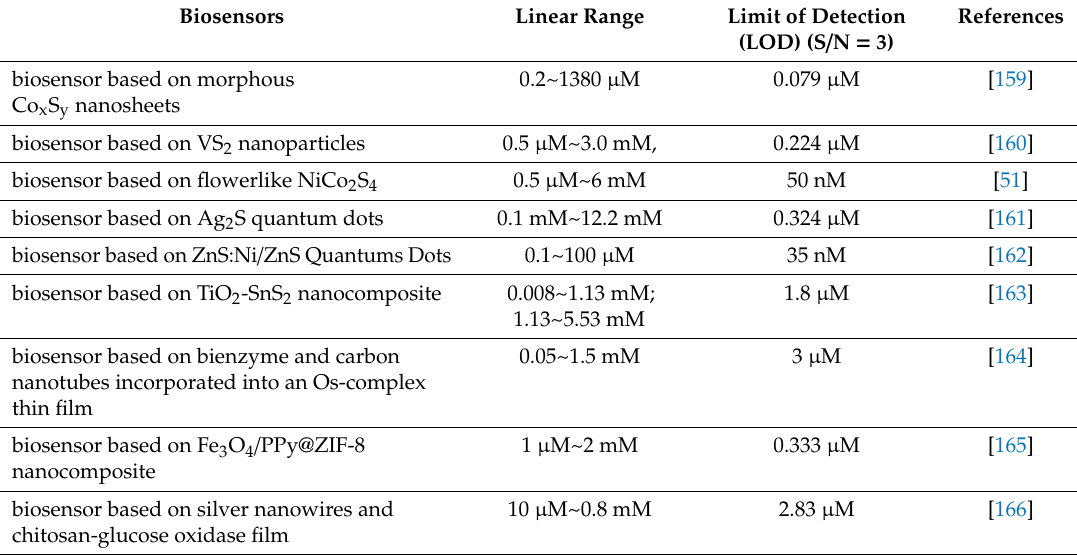
Table 4. Brief comparison between biosensors based on sulfur-containing nanomaterials and